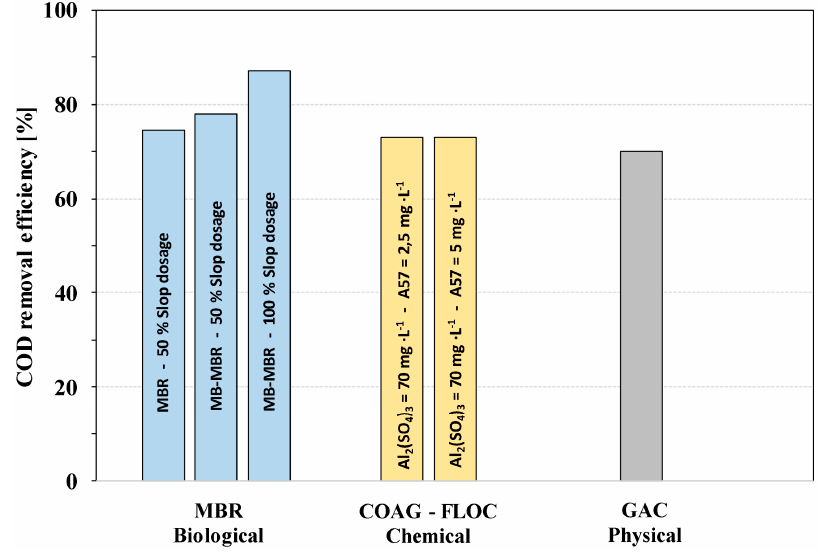
Figure 3. COD removal efficiency of the biological (MBR), chemical (coagulation-flocculation) and Physical (GAC) treatments of slop.